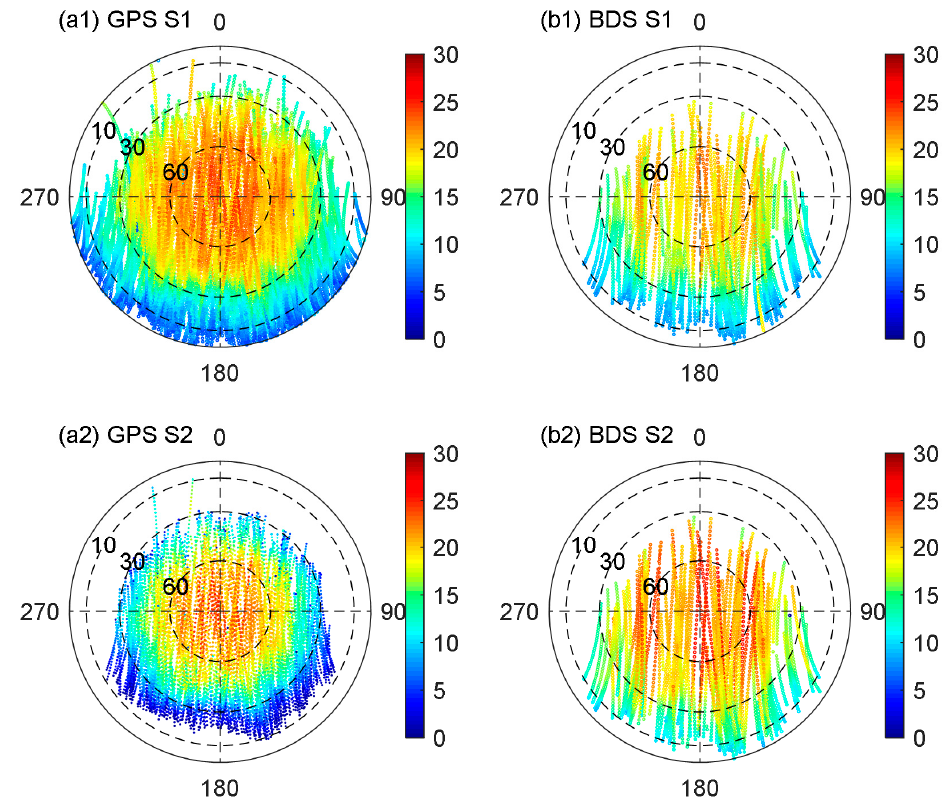
Figure 2. Sky-plots of Signal to Noise Ratio (SNR) (unit: dB-Hz) of GPS and BDS observations on date of year (DOY) 202, 2018. The ( a1 ) and ( a2 ) panels show the SNR of GPS L1 (S1) and L2 (S2); the ( b1 ) and ( b2 ) panels show the SNR of BDS B1 (S1) and B2 (S2).